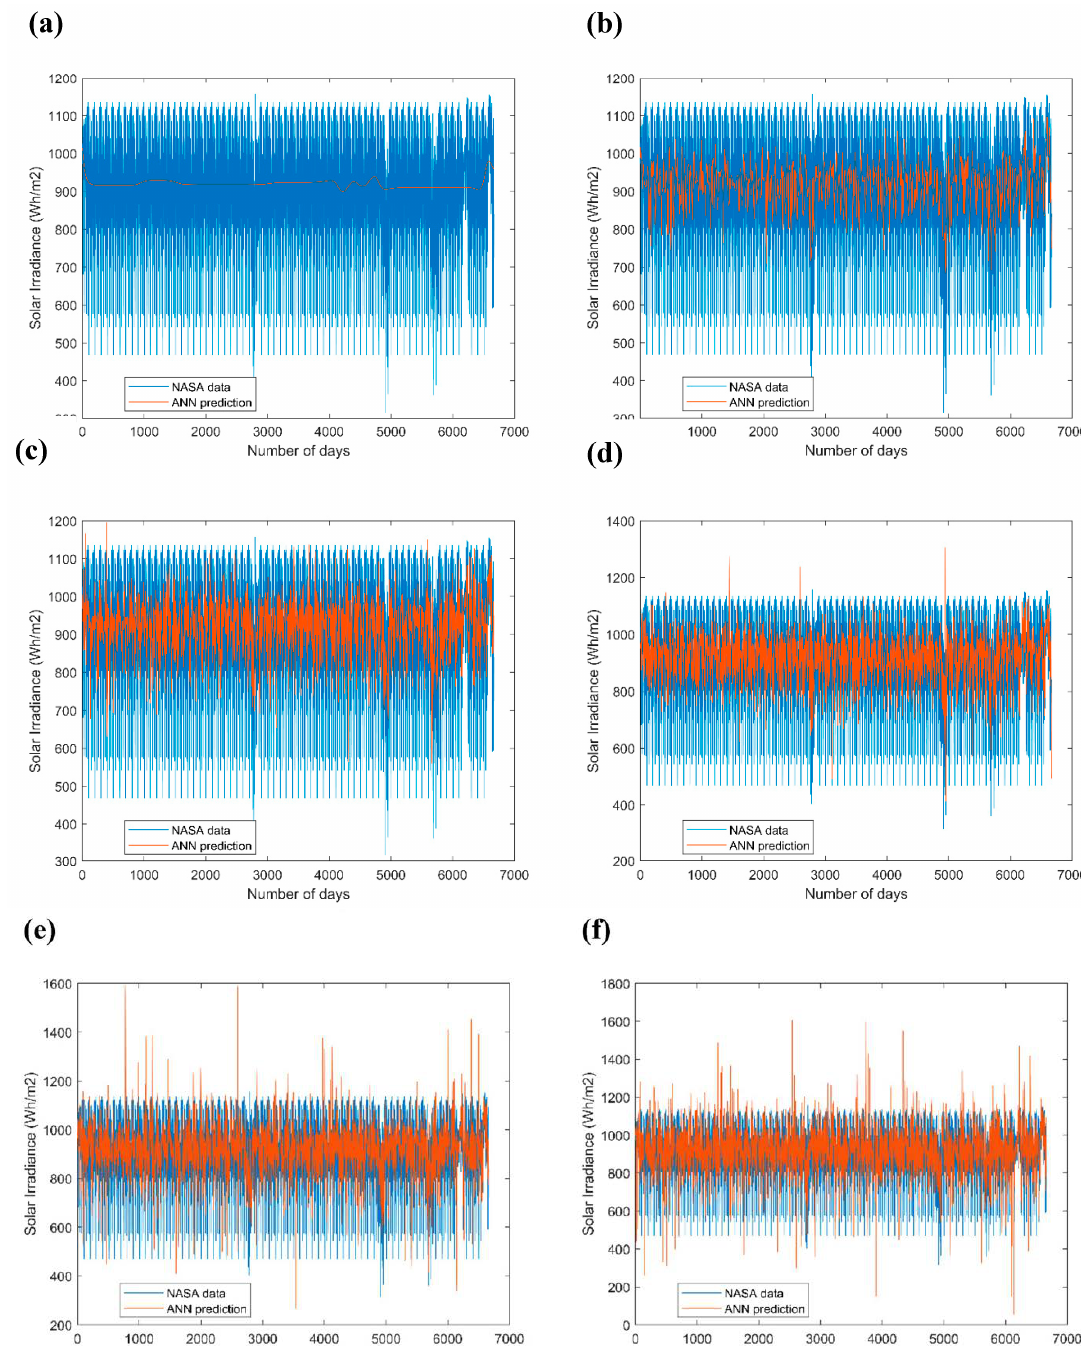
Figure 9. Solar irradiance plot of the NASA data vs. the ANN model with ( a ) 10 hidden units, ( b ) 500 hidden units, ( c ) 1000 hidden units, ( d ) 1500 hidden units, ( e ) 2000 hidden units, and ( f ) 2500 hidden units.